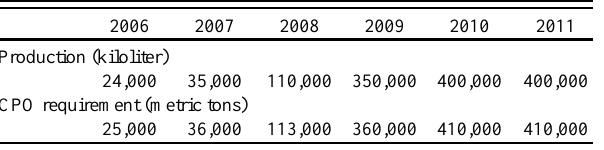
Table 2 . Indonesian biodiesel production and the use of palm oil. CPO = crude palm